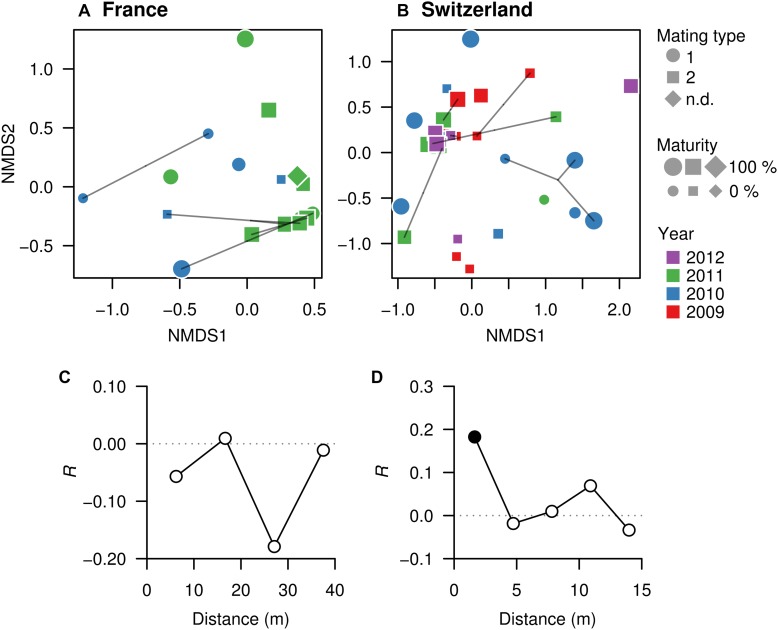
Microbial community similarities among truffles within orchards. (A, FR; B, SW) Non-metric multidimensional scaling (NMDS) ordinations based on Bray–Curtis dissimilarities of the OTU composition of microbiomes in truffle samples. The closer the samples, the more similar their microbiomes are. Different symbols denote mating type, symbol sizes represent maturity of fruiting bodies, and symbol colors represent collection year. Points linked with lines are fruiting bodies belonging to the same MLG. (C, FR; D, SW) Correlograms showing correlation of microbiome similarity among samples (y-axis, Mantel’s R) with spatial distance (x-axis). Solid and empty points denote significant (P < 0.05) and non-significant correlations for each distance class based on Bonferroni adjustment for multiple testing, indicating that space affects the truffles microbiomes in the Swiss but not the French site.